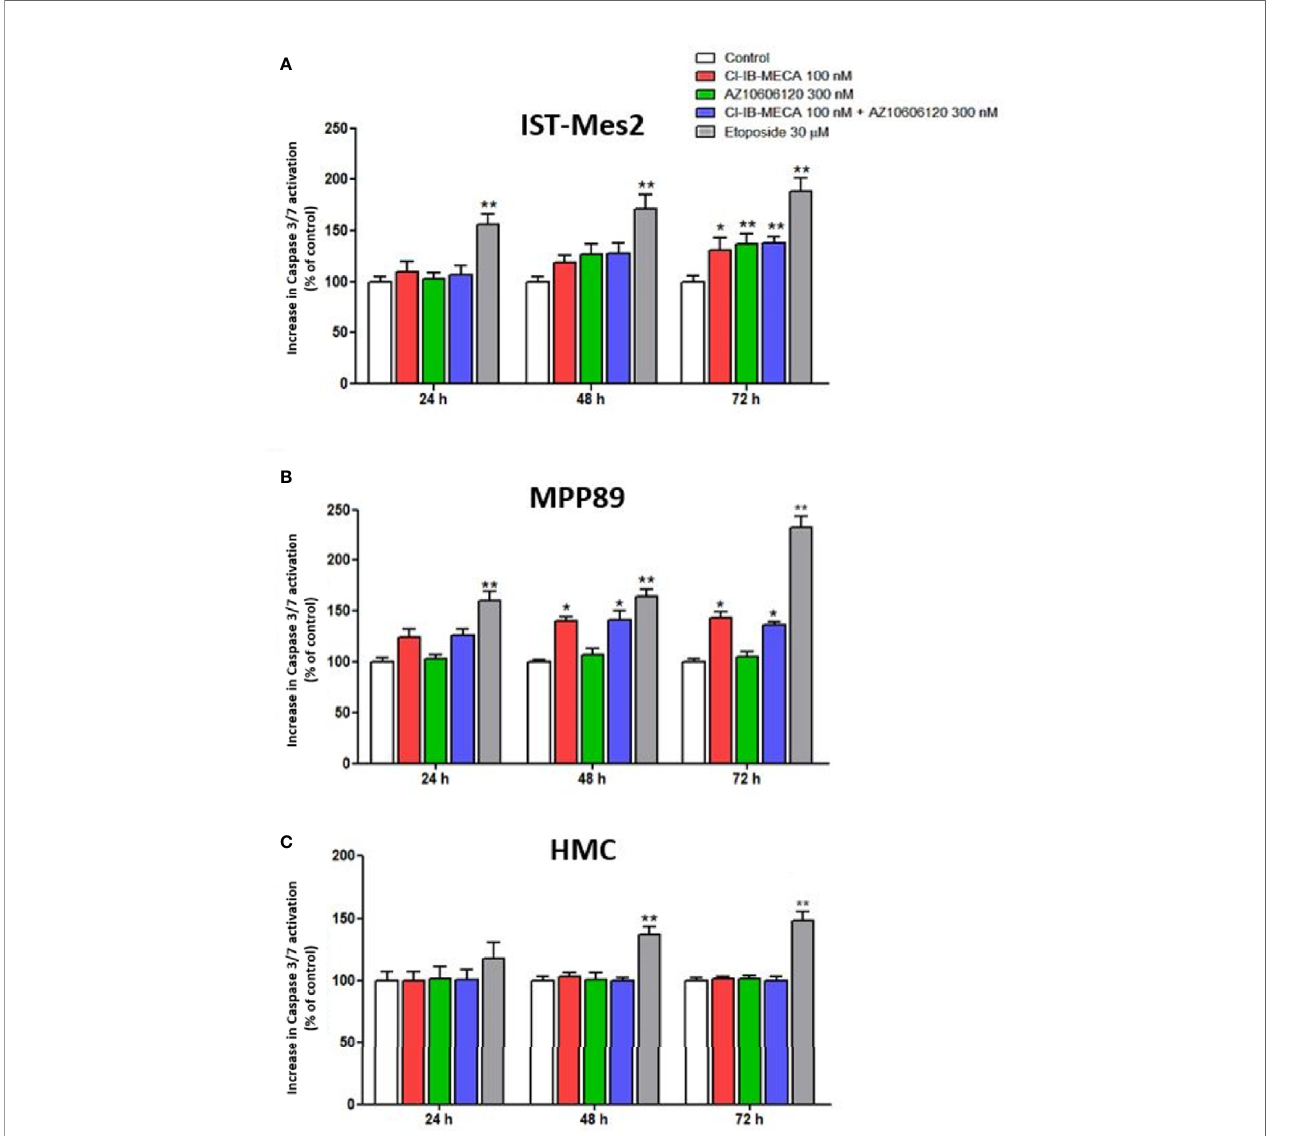
FIGURE 5 | Impact of A 3 AR agonist and P2X7R antagonist on apoptosis. Effect of Cl-IB-MECA (100 nM), AZ10606120 (300 nM), alone or in combination, in comparison to etoposide 30 µM on cell apoptosis in IST-Mes2 (A) and MPP89 (B) cells as well as in HMC cells (C) . The Caspase 3/7 activation was used as the apoptosis parameter/marker. Results are represented as mean ± standard error of mean (SEM) of n=3 independent experimental replicates. *p < 0.05 vs control; **p < 0.01 vs